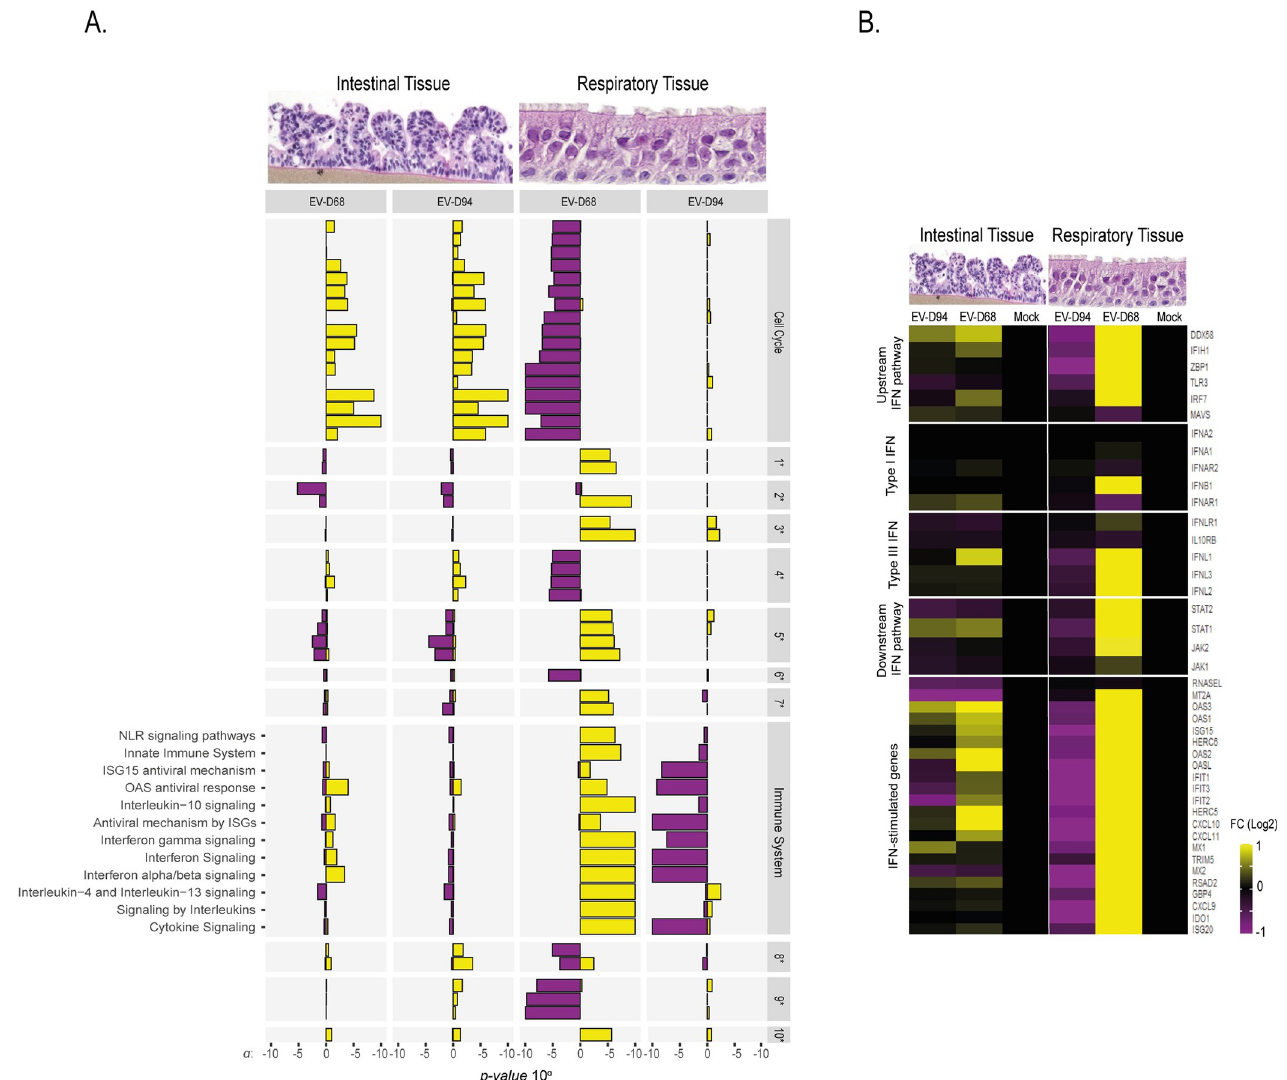
Fig 5. Significantly enriched pathways after infection by EV-D94 or EV-D68 in respiratory and intestinal tissues. A) . Genes with average log2 fold change increase/decrease of 0.5 versus the mock were considered for pathway analysis. Pathway with p-value < 0.00001 were classified as enriched. Yellow bars represent upregulated pathways while purple bars represent downregulated ones. Bar size illustrates p-value. 1 � Cell-Cell communication; 2 � Cellular responses to external stimuli; 3 � Developmental biology; 4 � DNA repair; 5 � Extracellular matrix organization; 6 � Gene expression (Transcription); 7 � Hemostasis; 8 � Metabolism; 9 � Organelle biogenesis and maintenance; 10 � Signal transduction. Functional annotations were obtained from reactome.org. B) Heatmap of selected immune genes. The FC values for each transcript are represented in S7 Fig. Images depicting intestinal and respiratory tissue sections were obtained from Mattek and from [25]. Another representation of these data is available in S6 Fig and at [http://genebrowser.unige.ch/enterovirus/].